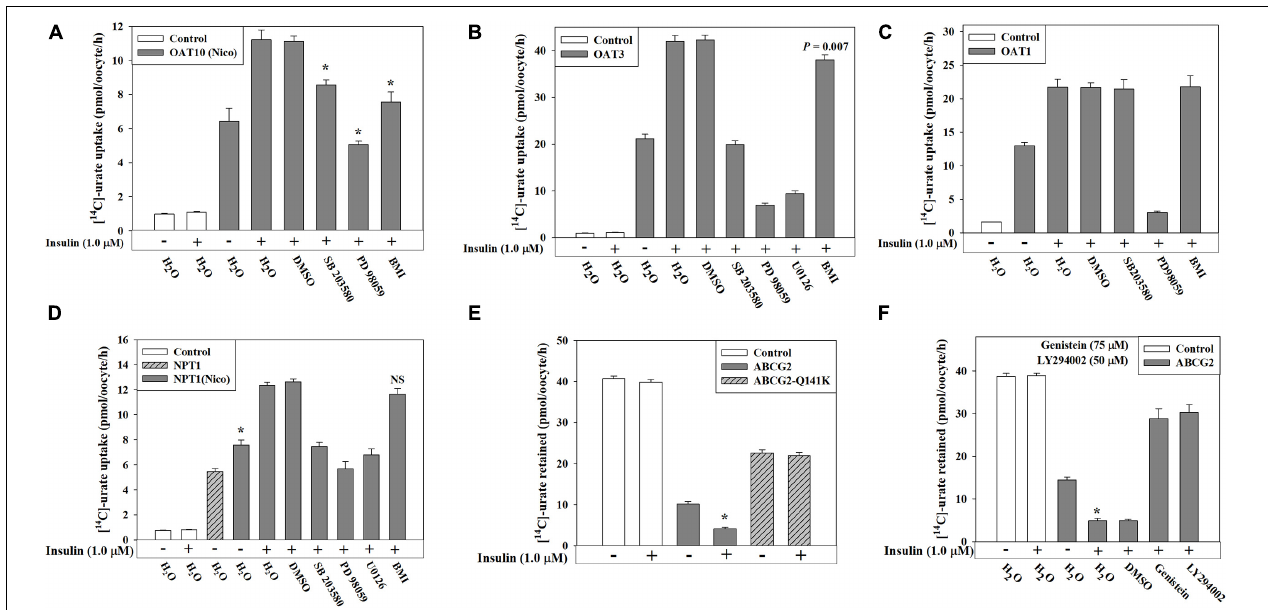
FIGURE 7 | Insulin-stimulation of [ 14 C]-urate uptake mediated by OAT10, OAT3, OAT1, NPT1 and ABCG2 in oocytes is inhibited by specific inhibitors of intracellular signaling pathways. (A–D) Insulin-stimulation of [ 14 C]-urate uptake mediated by human OAT10 (A) , mouse OAT3 (B) , human OAT1 (C) , or human NPT1 (D) , expressed in oocytes, was measured in the absence or presence 1.0 µ M insulin and p38 MAPK inhibitor (SB 203580; 10 µ M), MEK/ERK inhibitor (PD 98059/U0126; 20 µ M) or protein kinase C inhibitor (bisindolylmaleimide I hydrochloride, or BMI; 10 µ M) in K + -free isotonic medium. Oocytes expressing NPT1 were preloaded with nicotinate (Nico) by microinjection of 50 nl of 100 mM nicotinate 2 h before urate uptake. (E–F) Insulin-stimulation of [ 14 C]-urate efflux mediated by ABCG2 or ABCG2 mutant (Q141K) (E) , expressed in oocytes, was measured in the absence or presence 1.0 µ M insulin and/or genistein (75 µ M) or LY 294002 (50 µ M) (F) , in K + -free isotonic medium (pH 7.4) at ∼ 25 ◦ C. Asterisk (*), P < 0.001 compared with the urate uptake by urate transporters in the absence/presence of